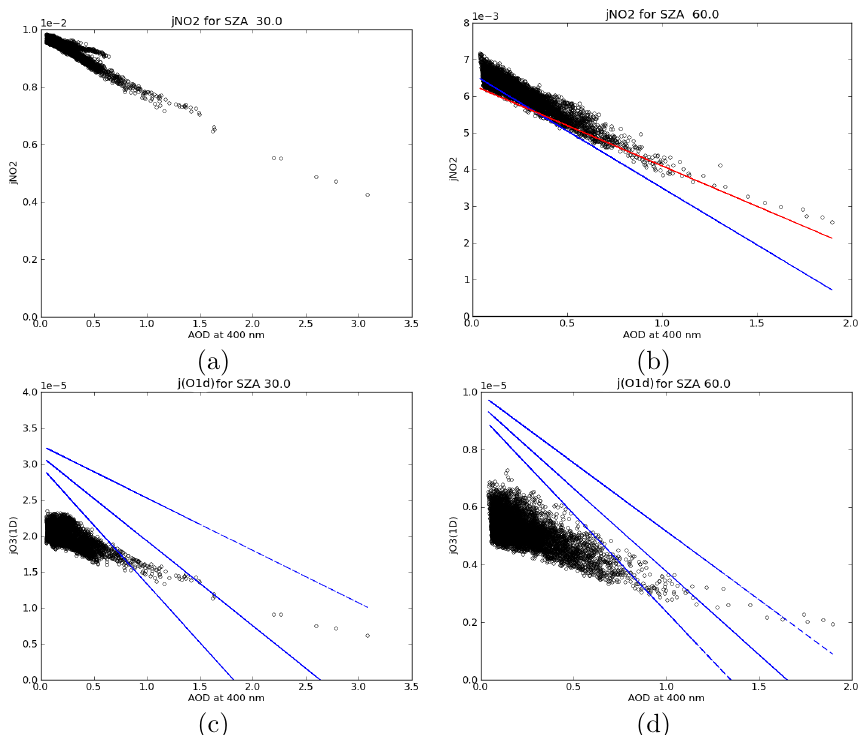
Figure 16. Scatter plots of J( NO 2 ) (a, b) and J (O 1 D) (c, d) at the lowest model level vs. the AOD, for clear-sky conditions ant latitudes comprised between 32.5 and 38.5 ◦ N. For the purpose of comparison, the regression relationships found by Gerasopoulos et al. (2012) with field data are reported in blue (non-dust aerosols) and red (dust aerosols) in panel (b) . In panels (c) and (d) the regression lines by Casasanta et al. (2011) are indicated along with their uncertainty margin.